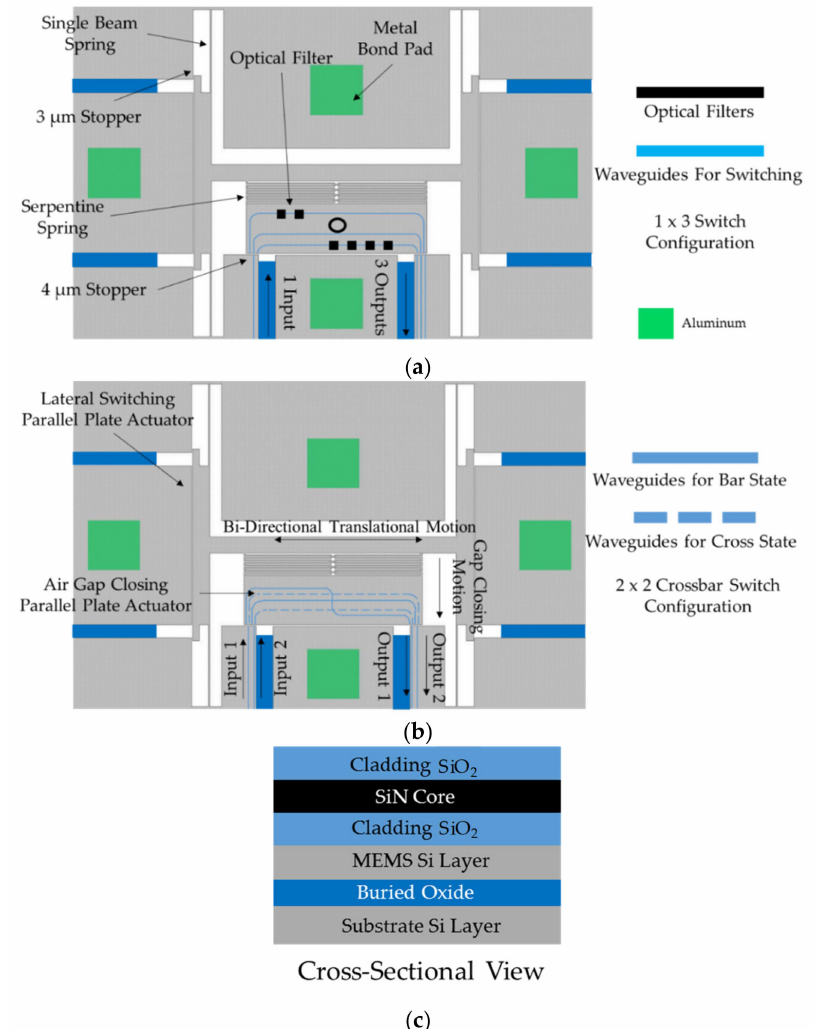
Figure 1. Illustrations of the proposed translational actuator: ( a ) 1 × 3 switch configuration with integrated optical filters; ( b ) 2 × 2 crossbar switch configuration; ( c ) cross sectional view of the optical MEMS stack proposed. The color scheme to represent the di ff erent materials is consistent throughout the